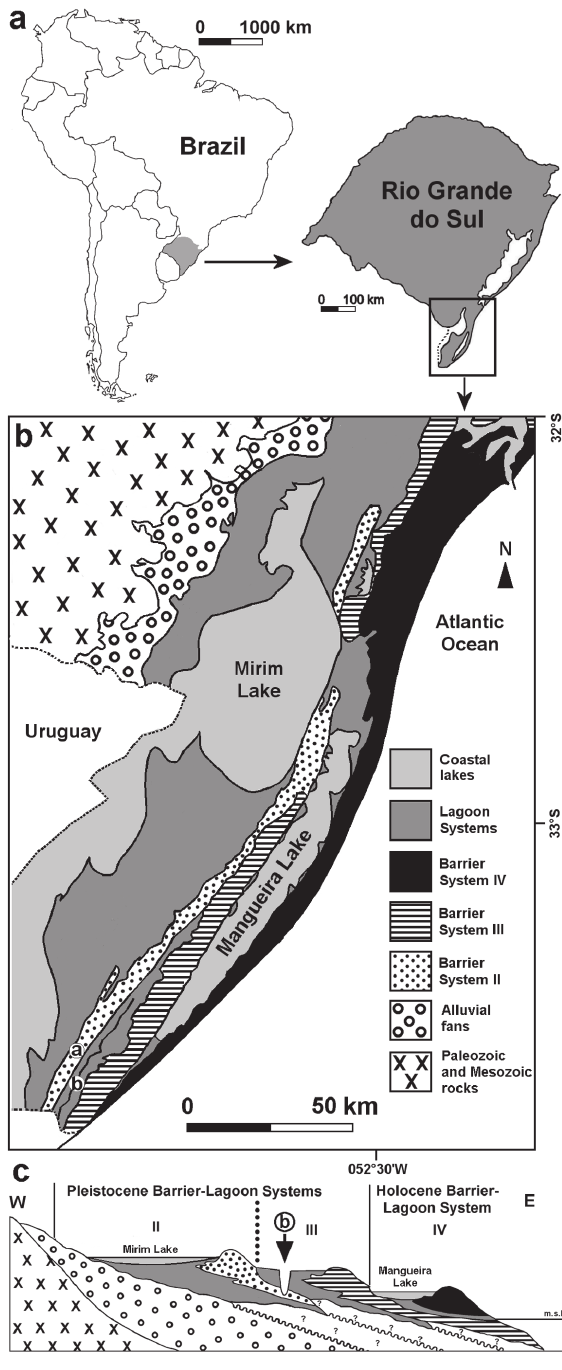
Figure 1 - a: location of the study area. b: geological structure of the southern CPRS. c: west-east transect of the depositional systems in the southern coastal plain (Modified from Villwock and Tomazelli 1995, Tomazelli and Villwock 2005, Rosa 2012). Localities mentioned in the text are Santa Vitória do Palmar (a) and Chuy Creek